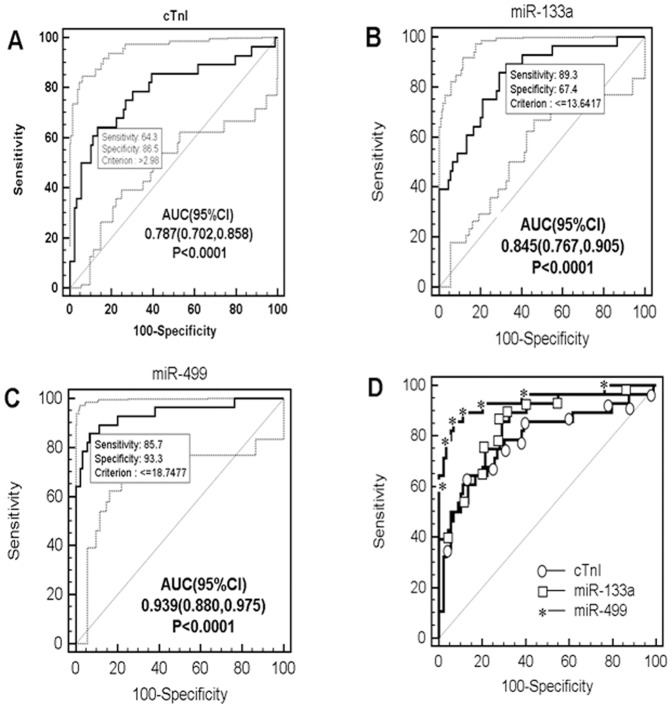
Receiver operating characteristic(ROC) curves for the identification of PMI at 6 hours after CABG.The thin diagonal line is the Null Hypothesis: True area = 0.50. A, B and C panels show the ROC and AUC values of cTnI, miR-133a and miR-499, respectively, as thick solid lines. The dotted lines show the 95% CI of ROC curves. The highest AUC was calculated from miR-499 (0.939, p<0.0001). (A) cTnI (>2.98 ng/ml) had a sensitivity of 64.3% and specificity of 86.5% for the identification of PMI. (B) miR-133a (ΔCt<13.6417) had a sensitivity of 89.3% and specificity of 67.4% for the identification of PMI. (C) miR-499 (ΔCt<18.7477) had a sensitivity of 85.7% and specificity of 93.3% for the identification of PMI. (D) Comparison of ROC curves of cTnI(ellipses), miR-133a(rectangles) and miR-499 (asterisks) at 6 h postoperatively. Abbreviations: AUC = area under the curve; Ct = cycle threshold; cTnI = cardiac troponin I; PMI = perioperative myocardial infarction.